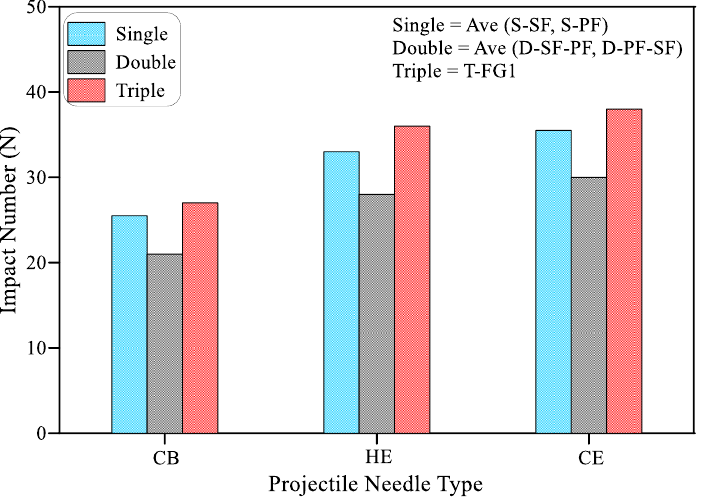
Figure 12. Effect of number of layers on the failure impact number (N) of the projectile impact test.